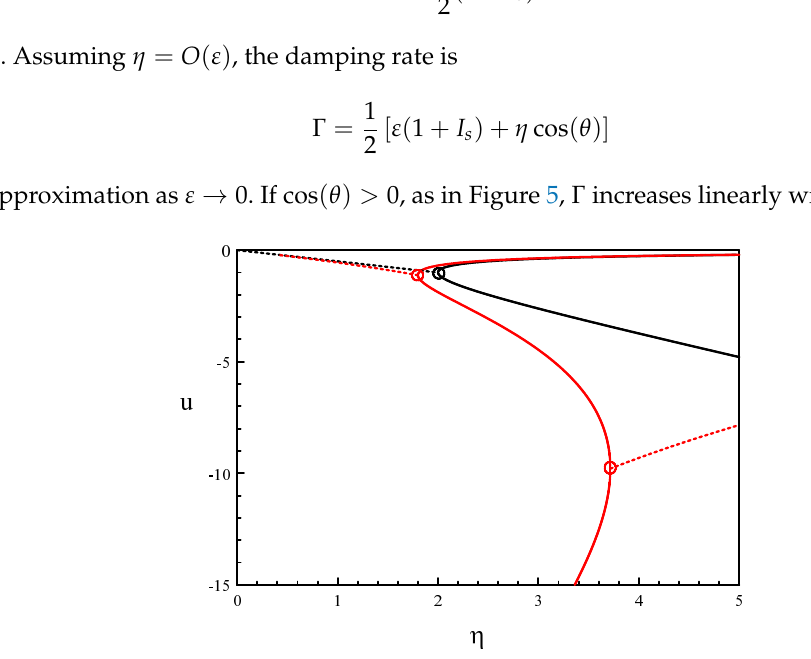
Figure 2. Real part u as a function of the feedback rate η for θ = 0 (black) and θ = 0.1 (red). The full and broken lines correspond to real roots ( v = 0 ) and complex roots ( v (cid:54) = 0 ) of the characteristic Equation (7), respectively. Transitions between real and complex roots occur at limit points (encircled).